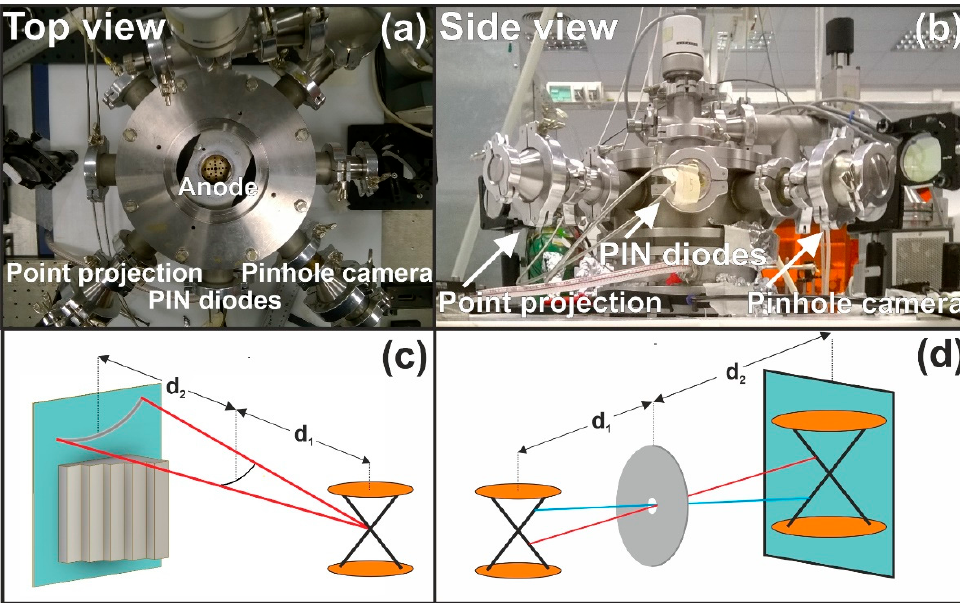
Figure 1. ( a ) Top and ( b ) side views of the vacuum chamber of the X-pinch device, and of the three diagnostics—namely, the X-ray point-projection radiography, the PIN diodes, and the pinhole camera. Illustration of the ( c ) point projection and ( d ) pinhole camera methodology.